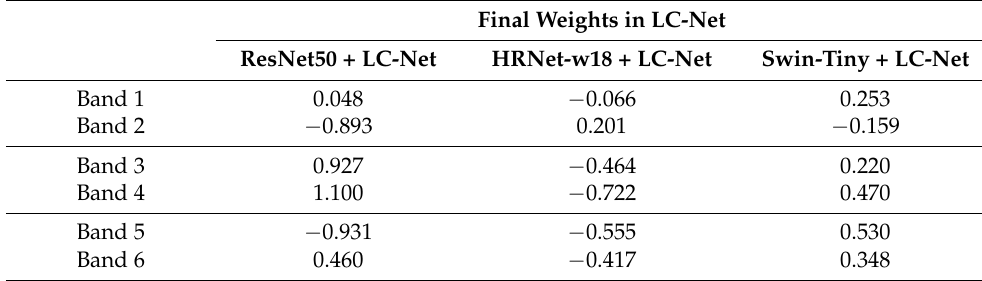
Table 7. Final weights in LC-Net used in the three networks